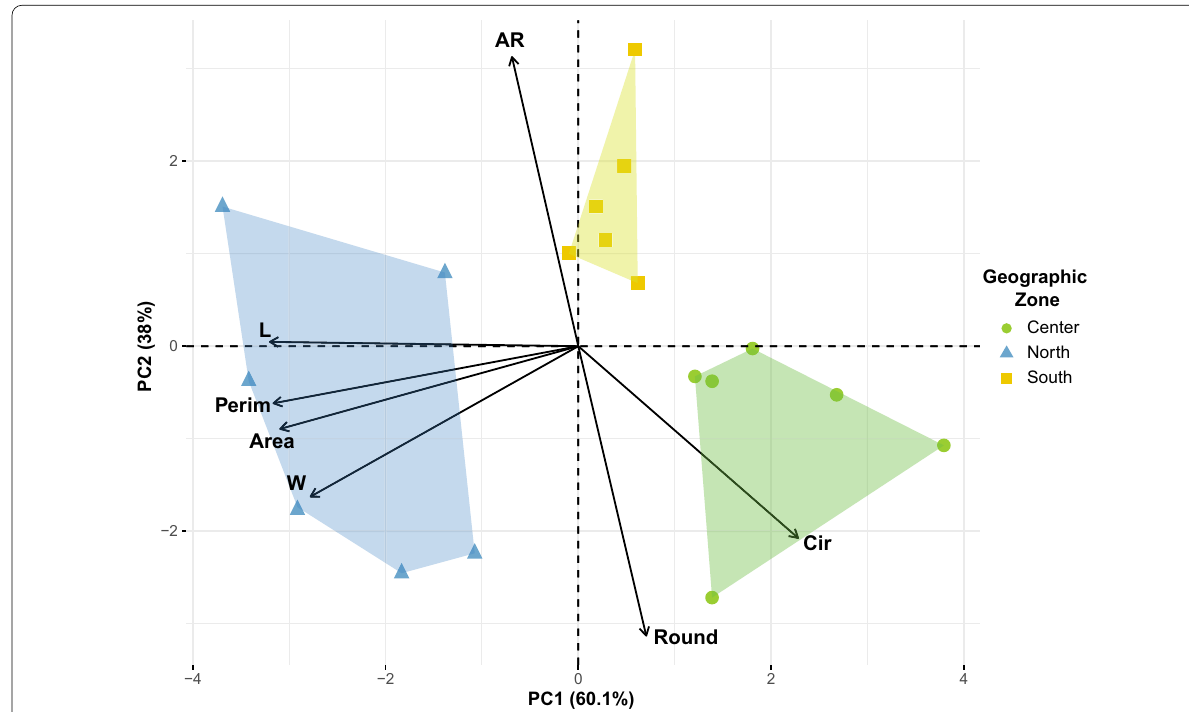
Fig. 2 Principal component analysis biplot of axes 1 and 2 (98.08% of variability) of carob seed traits belonging to different geographic zone. L : length, W : width, Perim: perimeter, AR: aspect ratio, Cir: circularity, Round: